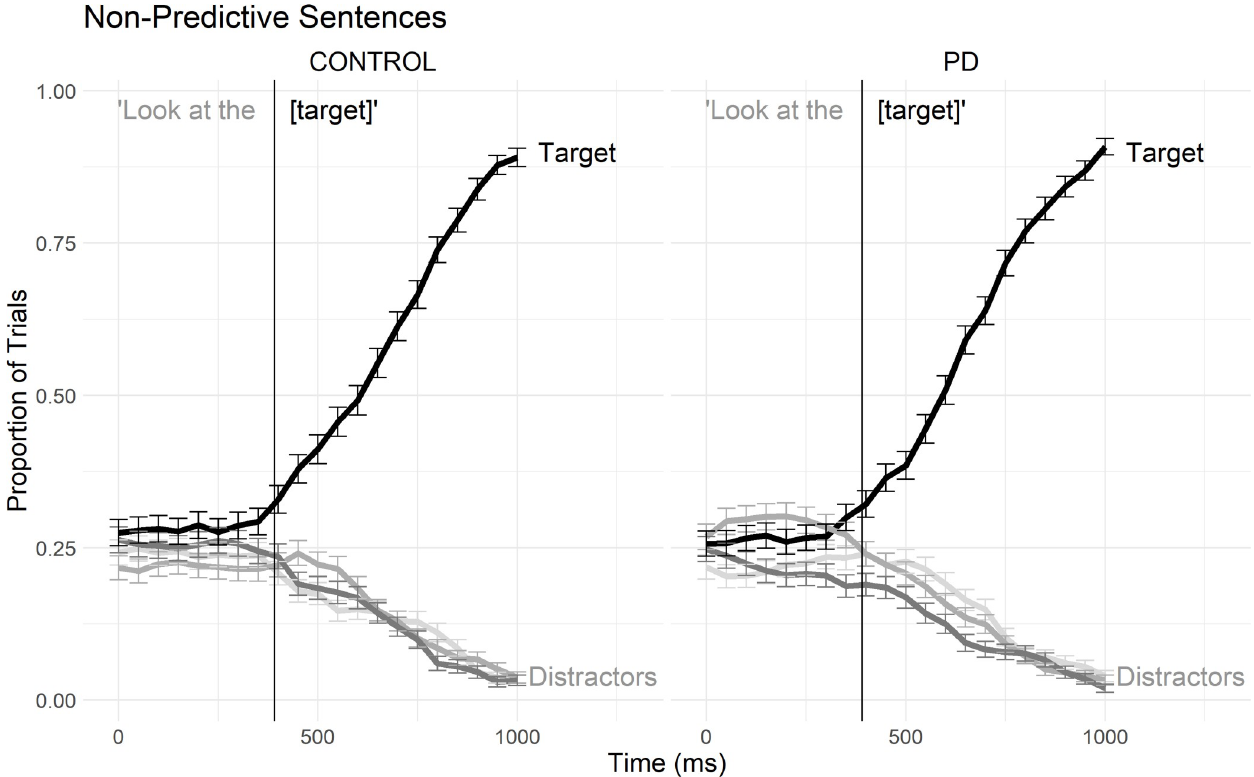
Fig 5. Gaze data by group in baseline sentences. Binned binomial gaze probabilities to each area of interest (AOI), averaged across subjects and trials over the duration of the non-predictive sentences for control participants (left) and PD participants (right). The x-axis reflects the elapsed time in the trial in milliseconds, offset by 200ms to account for saccade programming/launching time. The vertical line marks the onset of the target word. Error bars represent standard error of the mean.